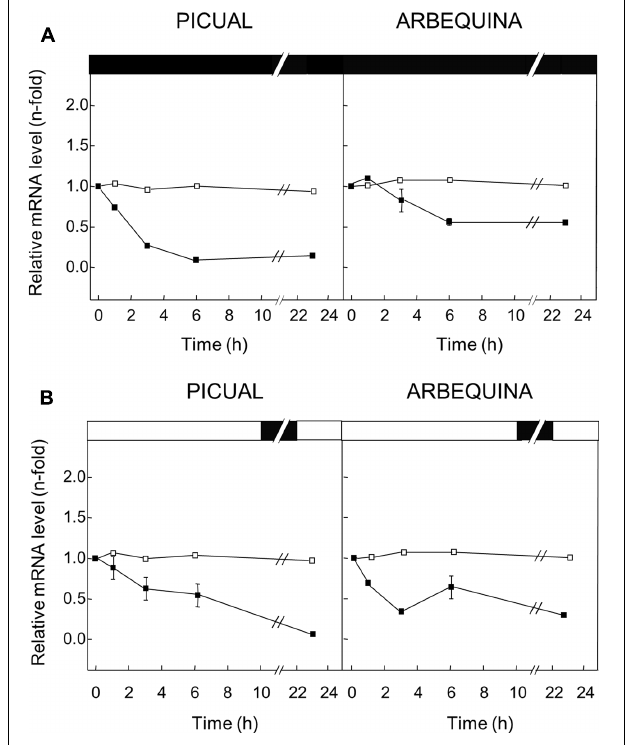
FIGURE 6 | Effect of darkness (A) and wounding (B) on the relative expression levels of olive GLU gene in the Picual and Arbequina mesocarp tissues. Branches with approximately 100 olive fruit at turning stage (28 WAF) were incubated using standard conditions (open squares), or incubated at 25 ◦ C for 24 h in the dark (A) or subjected to mechanical damage and incubated at standard conditions for 24 h (B) (closed squares). Boxes in the upper part indicate light (open) or dark (closed) periods.